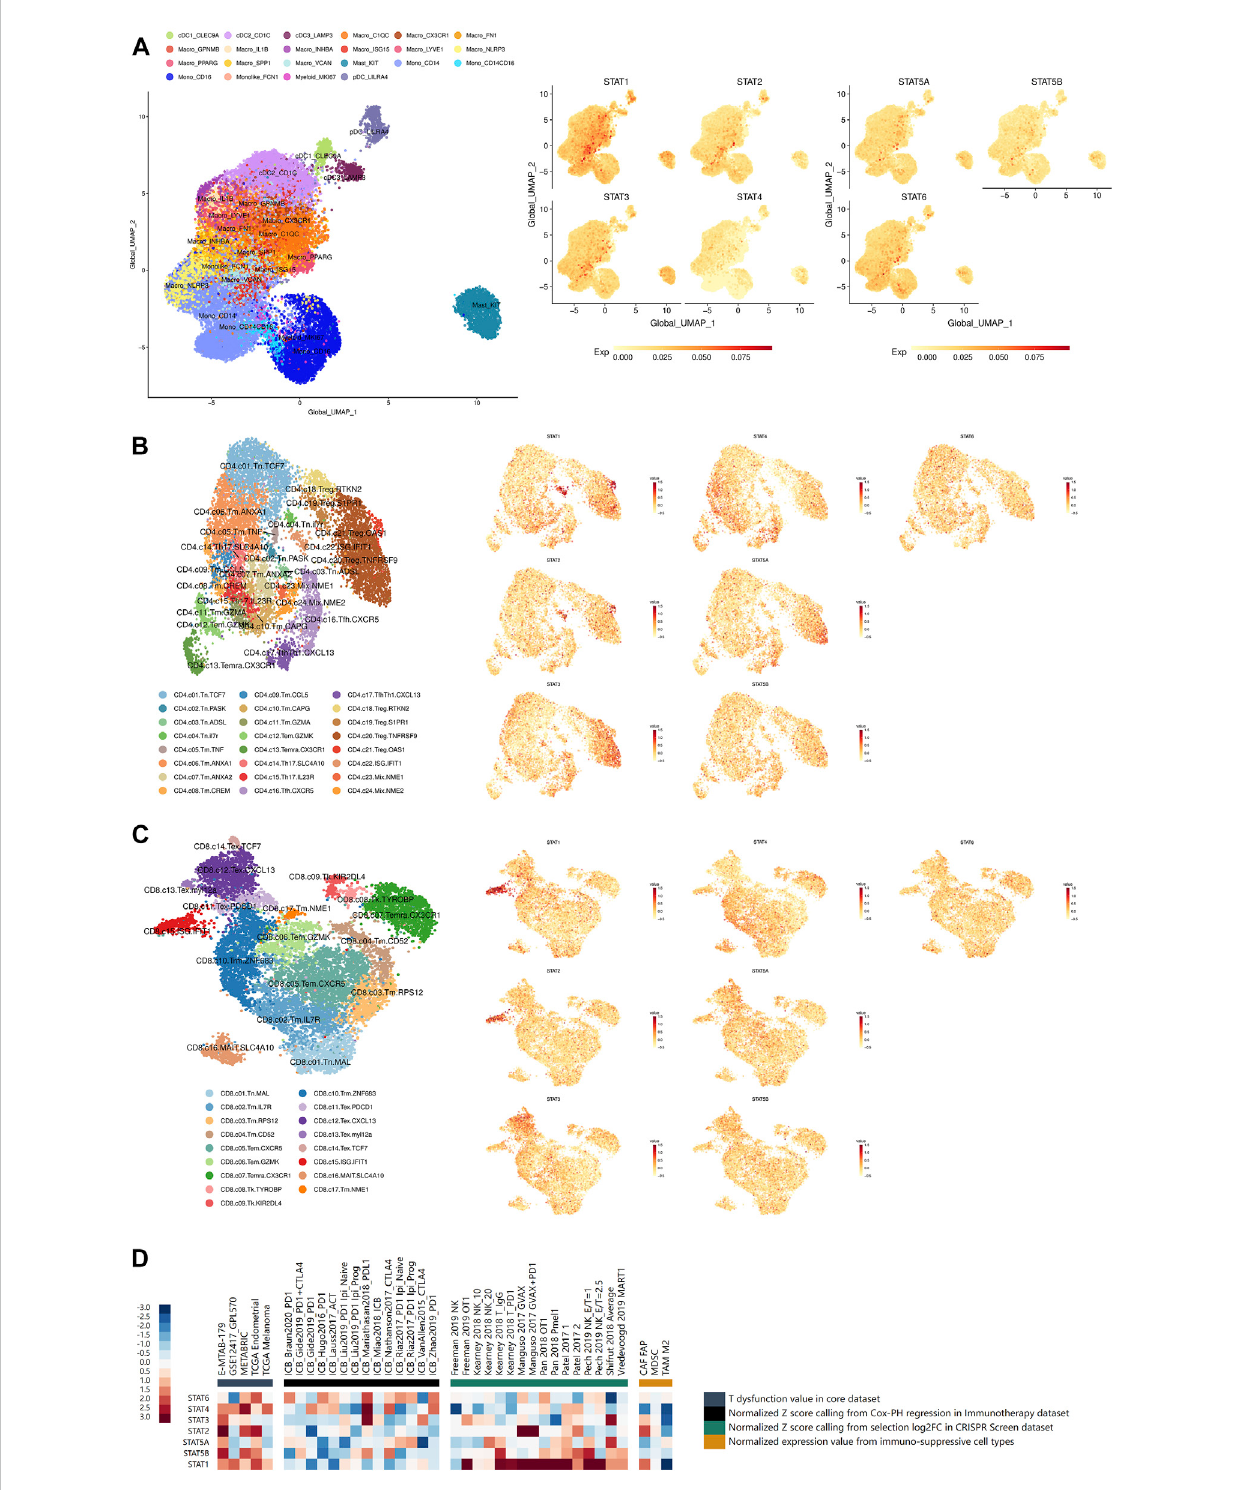
FIGURE 6 Immune in fi ltrationand immunotherapyrelated analysesofSTATs inpan-cancer. (A) UMAP featureplotsdepicting thedistribution ofSTAT1,STAT2, STAT3, STAT4, STAT5A, STAT5B, and STAT6 expression in myeloid cells in pan-cancer, which showed that STAT1 was remarkably high expressed in macrophages with marker ISG15, while STAT3 expression was signi fi cantly escalated in mast cells with marker KIT. (B) UMAP feature plots presented the distribution of STAT1, STAT2, STAT3, STAT4, STAT5A, STAT5B, and STAT6 expression in CD4 + T cells in pan-cancer, which revealed that STAT1 and STAT2 expression were notably up-regulated in CD4 + Treg cell with marker OSA1 and CD4 + T cell with ISG IFIT1. (C) UMAP feature plots exhibited the distribution of STAT1, STAT2, STAT3, STAT4, STAT5A, STAT5B, and STAT6 expression in CD8 + T cells in pan-cancer, which illustrated that STAT1 and STAT2 had prominent up-regulation in CD8 + T cell with ISG IFIT1. (D) Heatmap visualizing the correlation analysis between STATs expression and tumor immune dysfunction and exclusion-related factors including T dysfunction value in core dataset, normalized z score calling from Cox-PH regression in immunotherapy dataset, normalized z score calling from selection log2FC in CRISPR Screen dataset, and normalized expression value from immune- suppressive cell